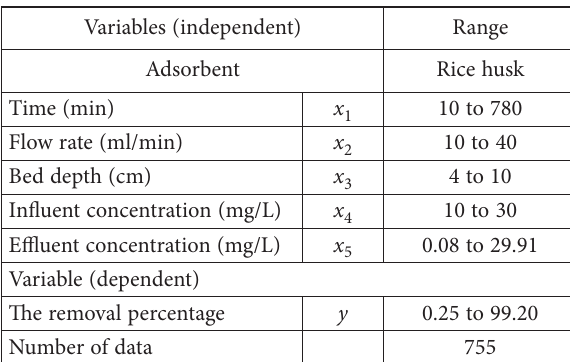
Table 4. Range of the variables